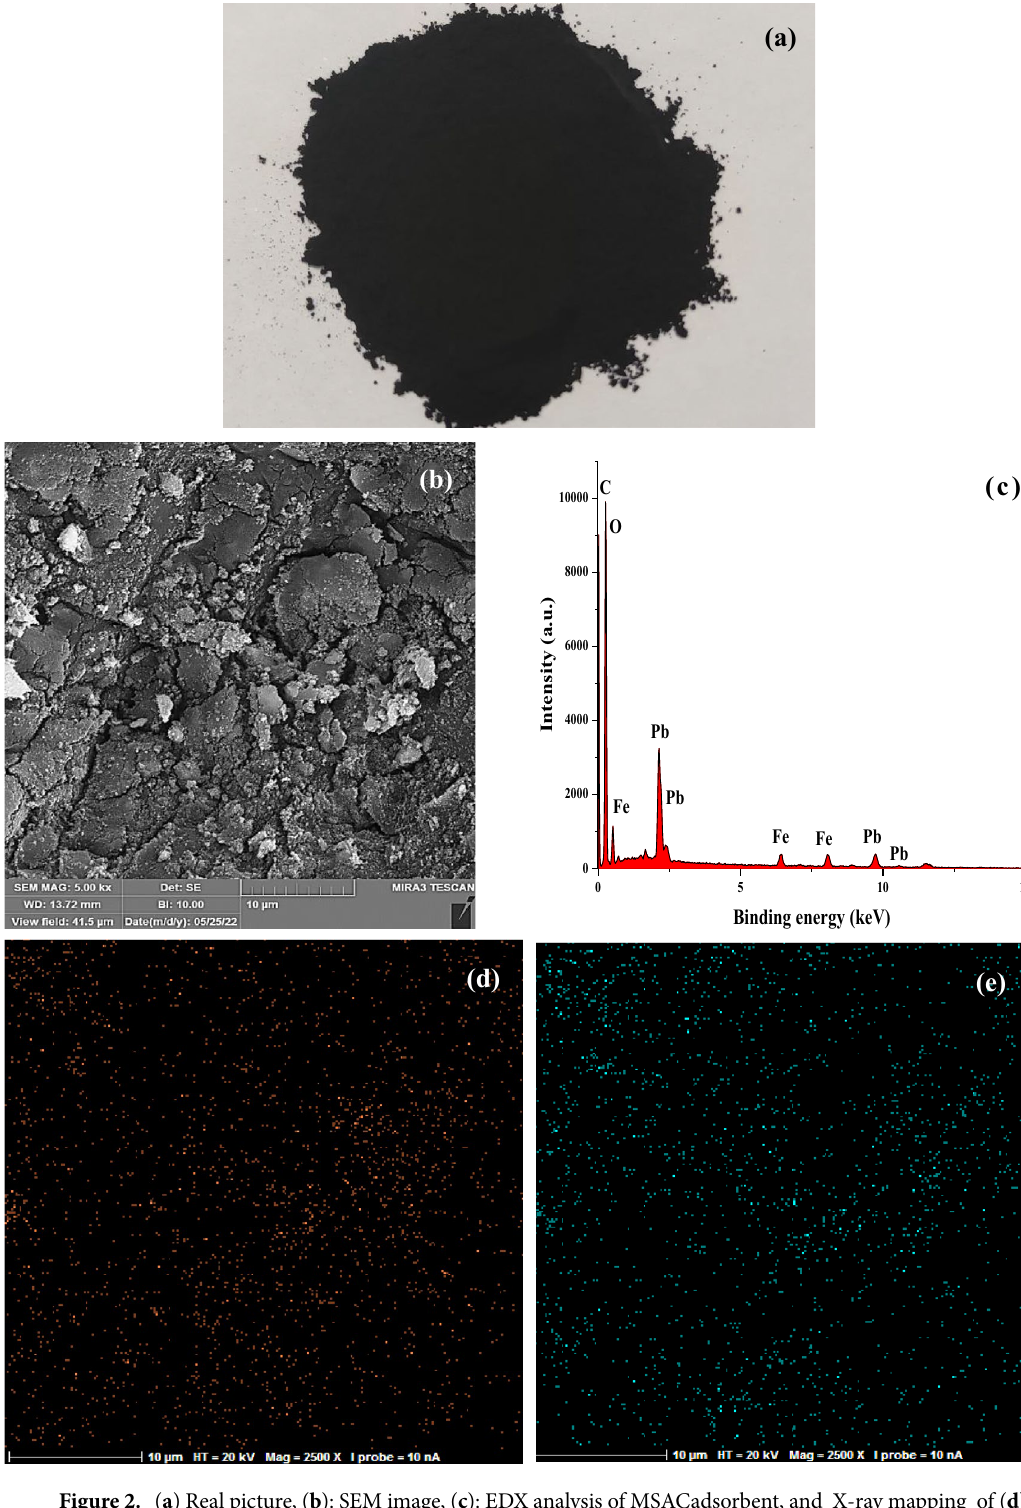
Figure 2. ( a ) Real picture, ( b ): SEM image, ( c ): EDX analysis of MSACadsorbent, and X-ray mapping of ( d ): lead, and ( e ): iron in